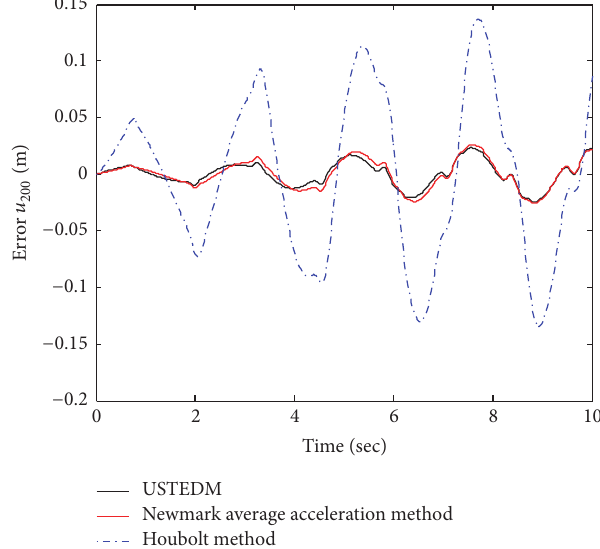
Figure 7: Comparison of displacement errors of 200-DOF